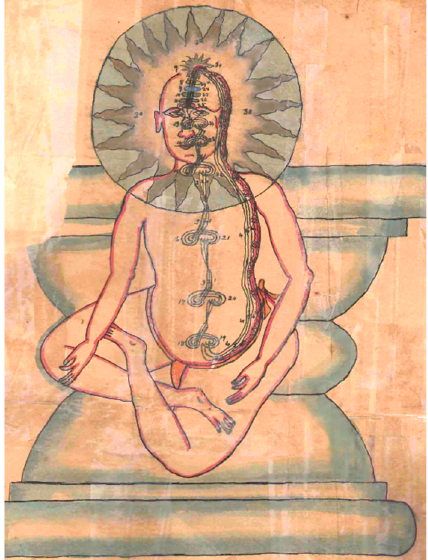
Figure 5. The yogic body understood as a set of superimposed bodies—material and spiritual bodies that coexist and interconnect, showing the “subtle body” ( li ṅ ga- ś ar ī ra ) and “material body” ( sth ū la- ś ar ī ra ). Representation of 1880 (treatise on Vedantic Raj Yoga Philosophy. Edited by Siris Chandra Basu, Student, Government College. Publisher: Lahore “Civil and Military Gazette” Press. Ś r ī Sa-